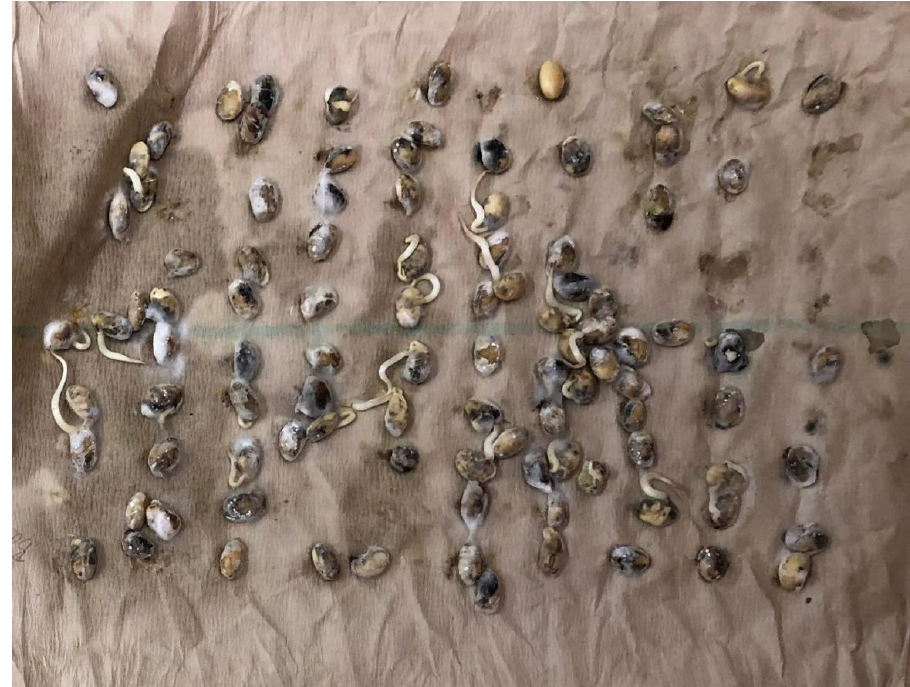
Figure 1. Seven days after initiation of germination and seedling vigor test. Incubators set at. 25 °C on continuous light. An image representing seedling germination and vigor of infected soybean seedlings. The field experiment was conducted in 2019 at the Delta Research and Extension Center in Stoneville, MS.